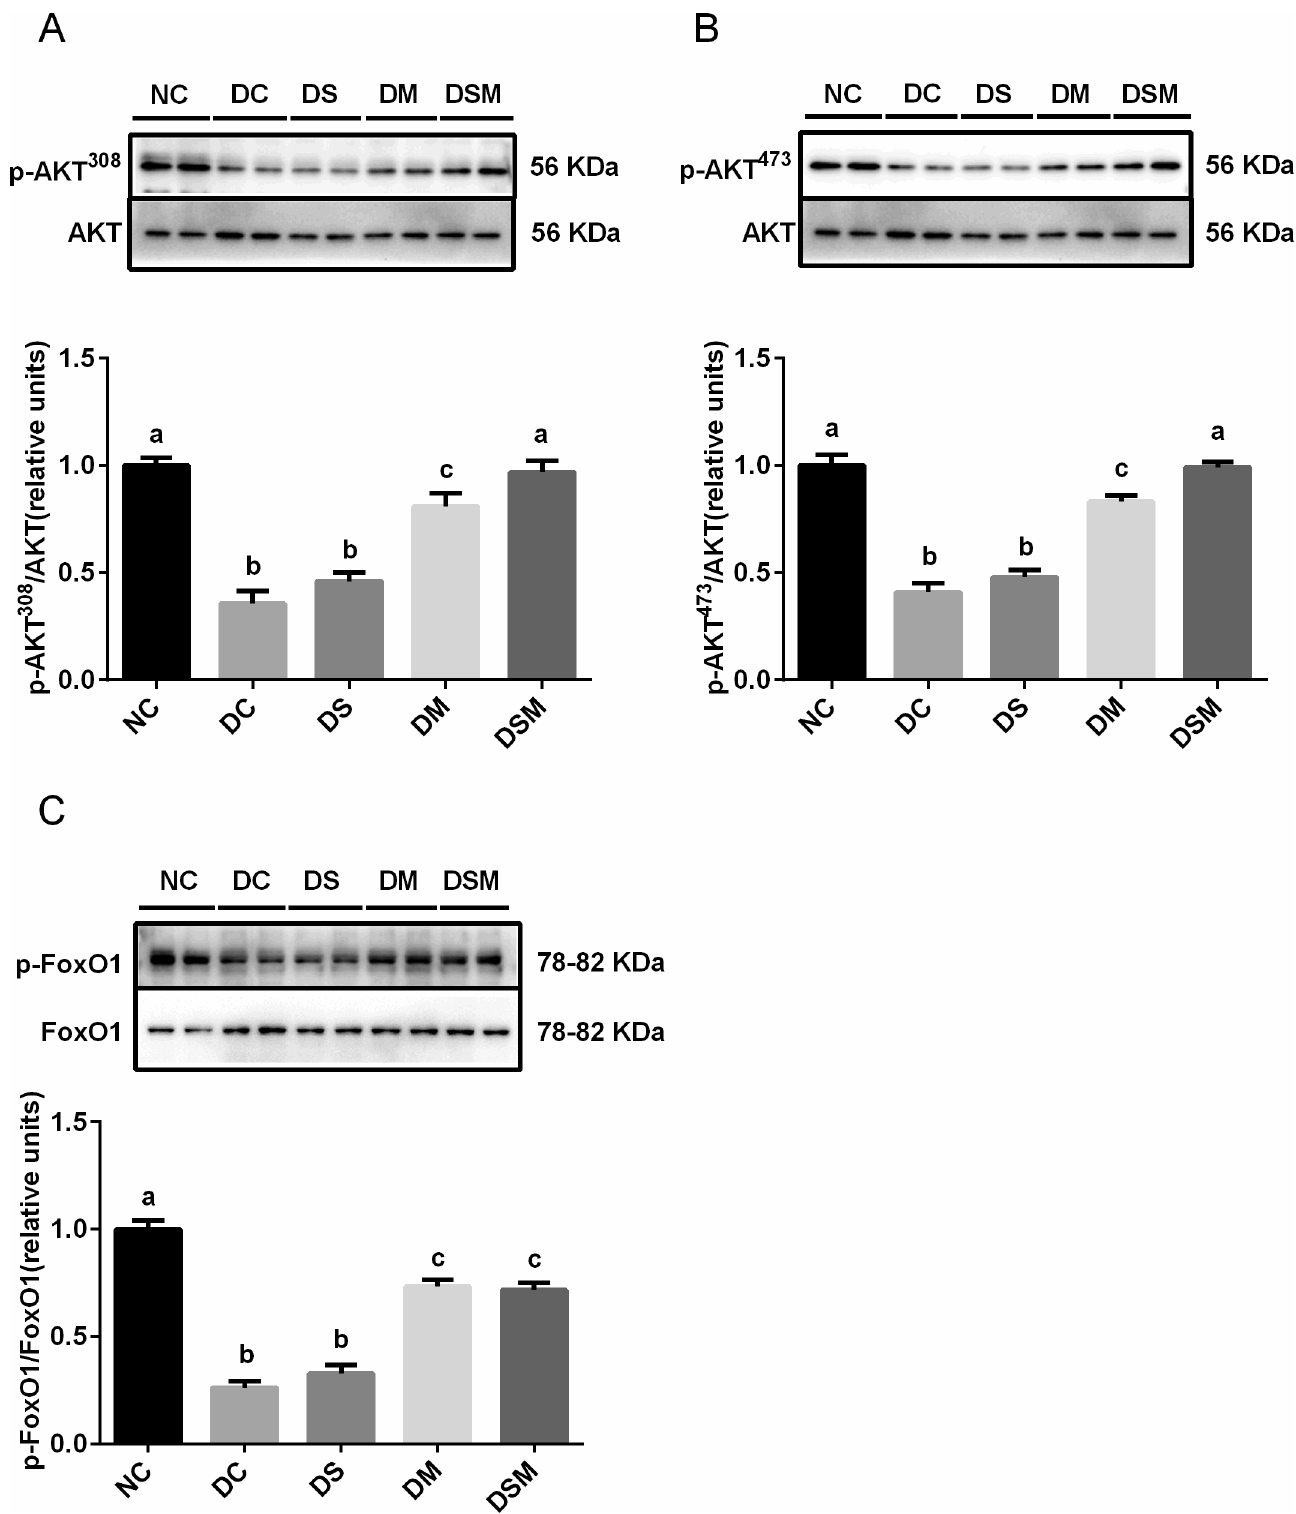
Fig 6. Combined intervention of swimming plus metformin improves the insulin signaling in skeletal muscle tissues under GDM condition. Thr308 phosphorylation levels of AKT (p-AKT T308) were normalized to total AKT in the skeletal muscle treated with swimming or metformin or both combined. (B) Levels of phosphorylated serine-473 AKT (p-AKT S473) were normalized to total AKT in the skeletal muscle treated with swimming or metformin or